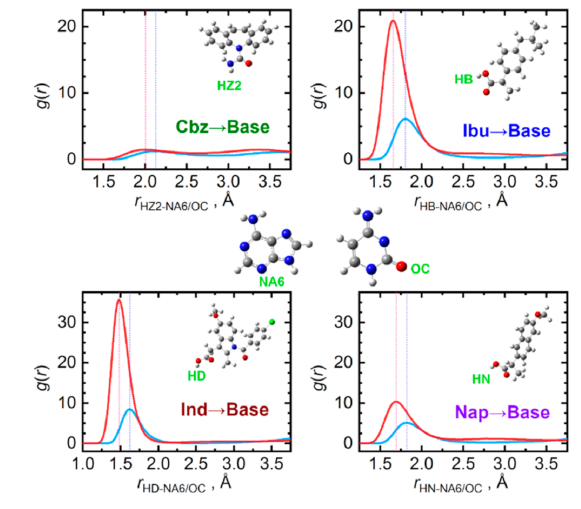
Figure 7. Hydrogen bonding between API (hydrogen donor) and nucleobase (hydrogen acceptor) molecules in the liquid phase at 410 K. Radial distribution functions are given for the most significant contacts in equimolar mixtures of API with adenine (light blue) and cytosine (red).